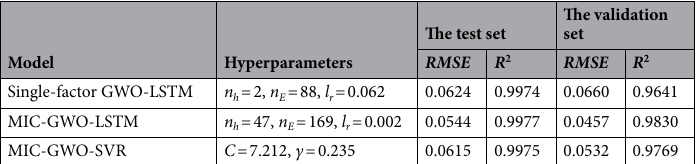
Table 2. Prediction results of the different prediction model.